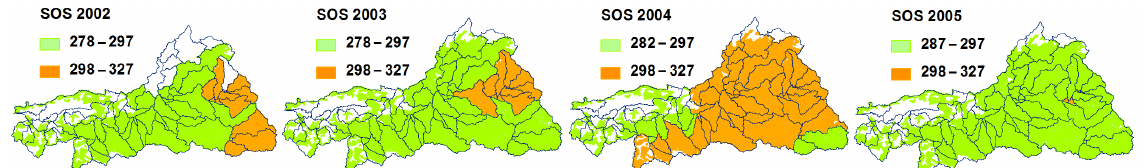
Figure 9. The interannual and spatial variation of the start of the rainy season for the savanna vegetation in the Mara River basin for 2002– 2005. Note that HRU level Julian dates are used and the sub-basins are overlaid.